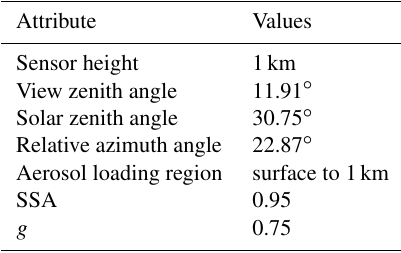
Table 3. Inputs for the 2S-ESS model